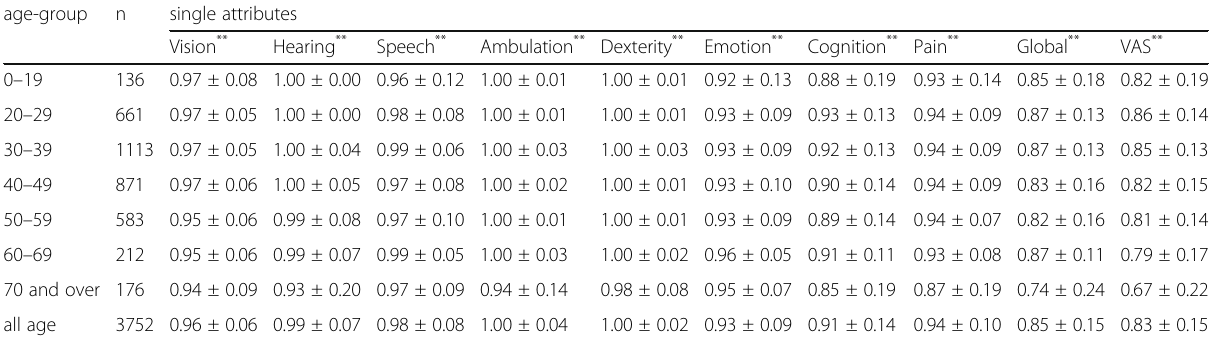
Table 3 Mean Utility Scores (Single Attribute, Multiattribute Global HUI3)and VAS score by Age Group